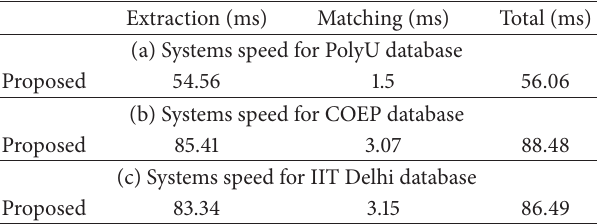
Table 2: Computation time for key processes both local and global